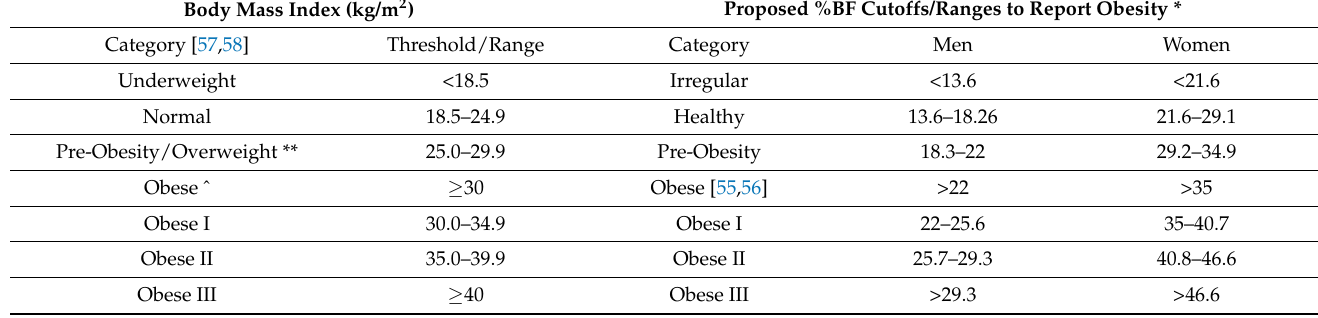
Table 7. Proposed total percent body fat (%BF) threshold and ranges as they relate to standard body mass index